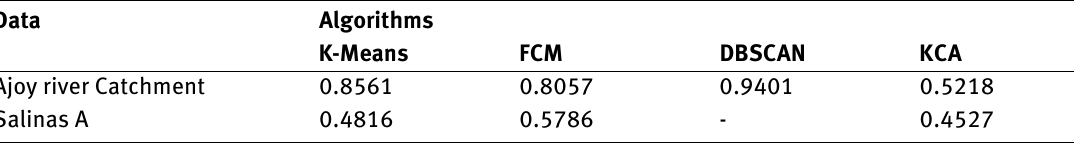
Table 9: Median values of performance index DB for 10 consecutive runs chosen three approaches Data